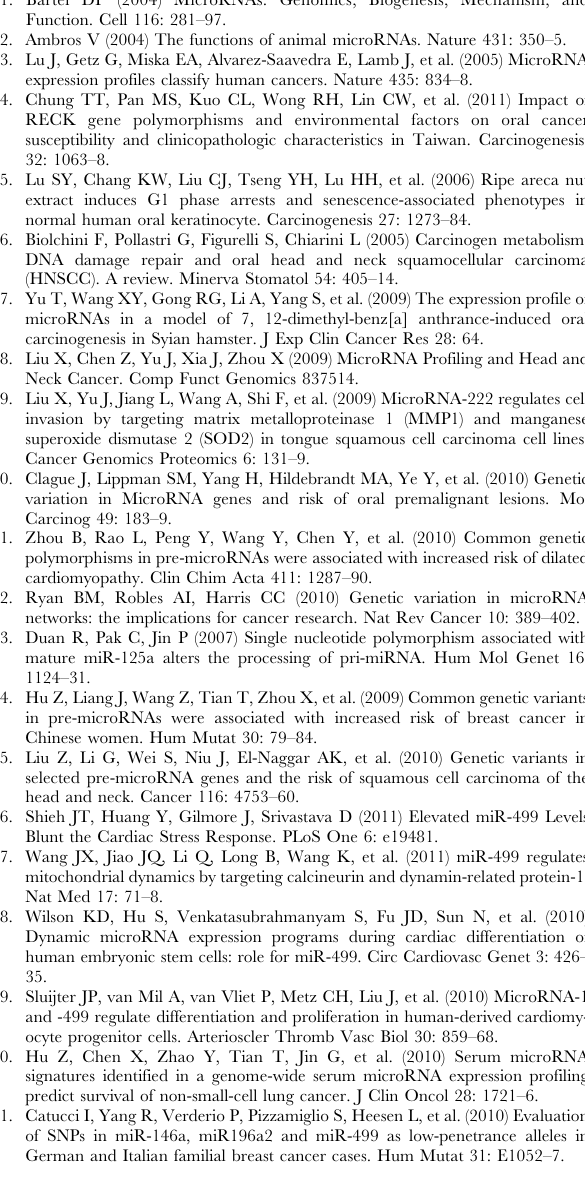
Table S3 Relationship of clinical status and miRNA499 genotypes in oral cancer patients ( # 60 only, N = 332). Table S4 Relationship of clinical status and miRNA499 genotypes in oral cancer patients ( . 60 only, N = 138).